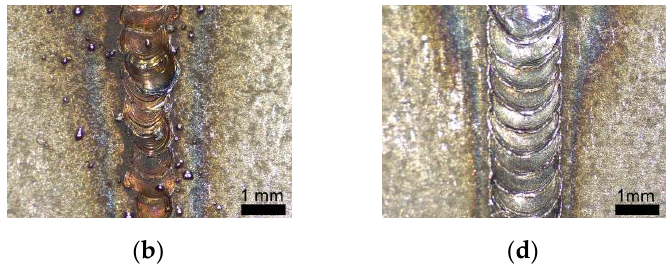
Figure 9. Comparison of the surface aspect of: Sample 3 ( a ) weld and ( b ) root face; Sample BS ( c ) top and ( d ) bottom layer.